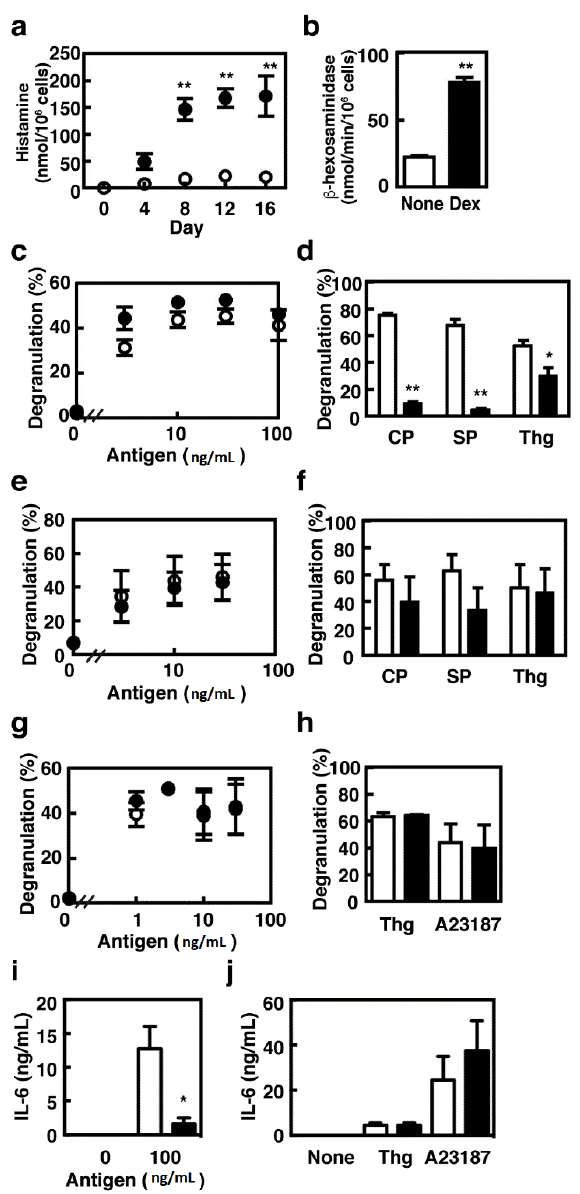
Figure 3. ( a , b ) The cellular histamine contents and enzymatic activities of β -hexosaminidase in the mast cells co-cultured for 16 days in the presence (closed circles) or absence (open circles) of 1 µM dexamethasone were measured. ( c – f ) The co-cultured mast cells were sensitized with IgE (1 µg/mL, clone IgE-3) for 3 h and then stimulated with the indicated concentrations of the antigen, or stimulated with compound 48/80 (CP, 10 µg/mL), substance P (SP, 100 µM), or thapsigargin (Thg, 300 nM) without sensitization. Degranulation upon IgE-mediated antigen stimulation ( c ) and treatment with compound 48/80, substance P, or thapsigargin ( d ) was measured in the mast cells co-cultured for 16 days in the presence (closed circles or columns) or absence (open circles or columns) of 1 µM dexamethasone. ( e , f ) BMMCs were co-cultured for 16 days and were treated with 1 µM dexamethasone during the last 24 h (closed circles and columns). Degranulation was then measured as described above. ( g – j ) BMMCs were treated without (open circles or columns) or with 1 µM dexamethasone (closed circles or columns) for 24 h. The cells were then sensitized with 1 µg/mL IgE (clone IgE-3) for 3 h and stimulated with the indicated concentrations of the antigen or stimulated with thapsigargin (Thg, 300 nM) or A23187 (A23187, 1 µM). Degranulation ( g , h ) and IL-6 release ( i , j ) were measured. The degree of degranulation was determined by measuring β -hexosaminidase activity. Values are presented as the means ± SEMs (n = 3). Values with * p < 0.05 and ** p < 0.01 are regarded as